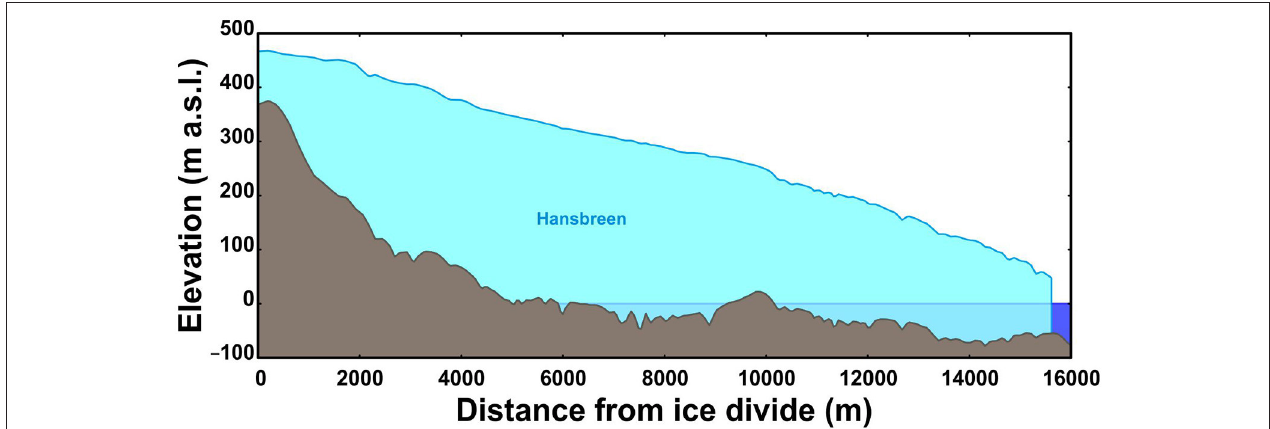
FIGURE 2 | Initial geometry of the modeled flowline representing Hansbreen in September 2008.